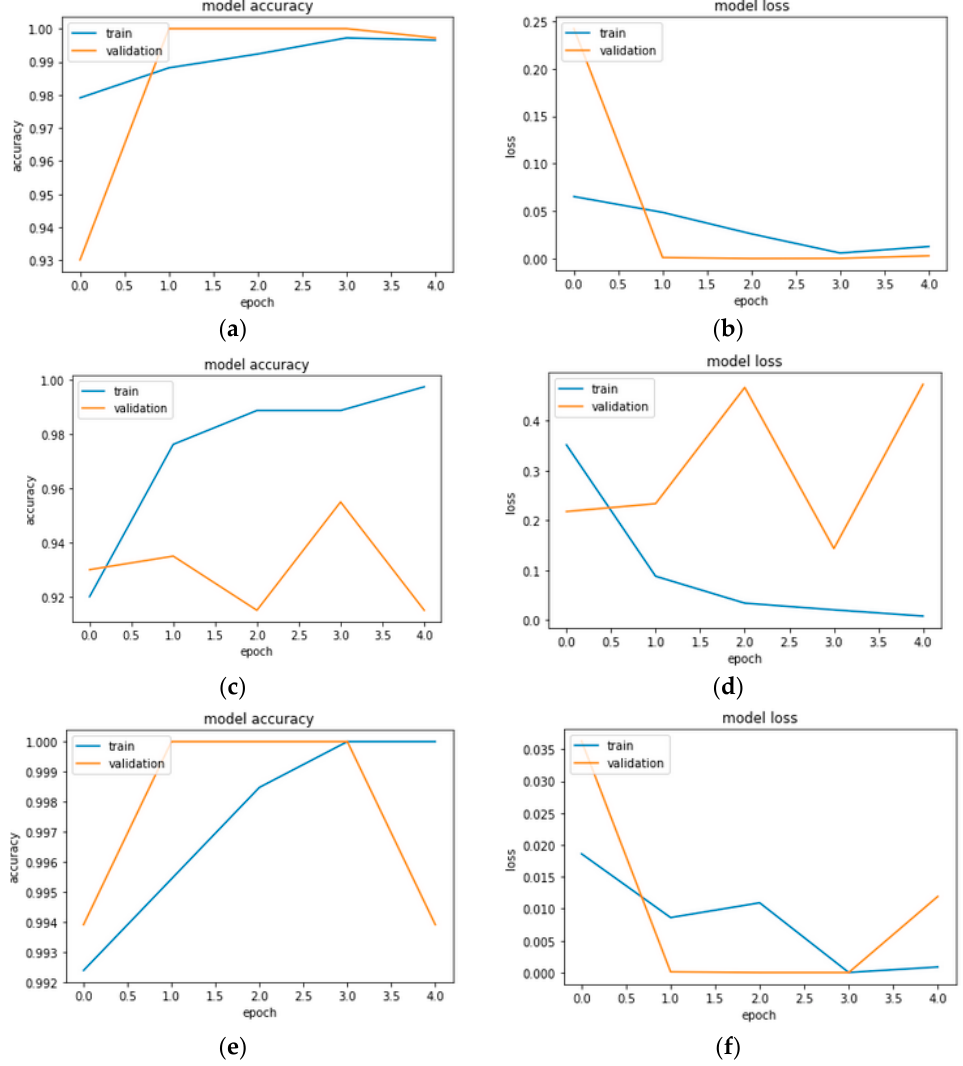
Figure 9. Validation and training analysis over five epochs of the pre-trained ResNet50 model using various datasets: ( a ) validation and training model accuracy analysis, using the Clarkson 2015 dataset; ( b ) validation and training model loss analysis, using the Clarkson 2015 dataset; ( c ) validation and training model accuracy analysis, using the IIITD dataset; ( d ) validation and training model loss analysis, using the IIITD dataset; ( e ) validation and training model accuracy analysis, using the ND_Iris3D_2020 dataset; and ( f ) validation and training model loss analysis, using the ND_Iris3D_2020 dataset.